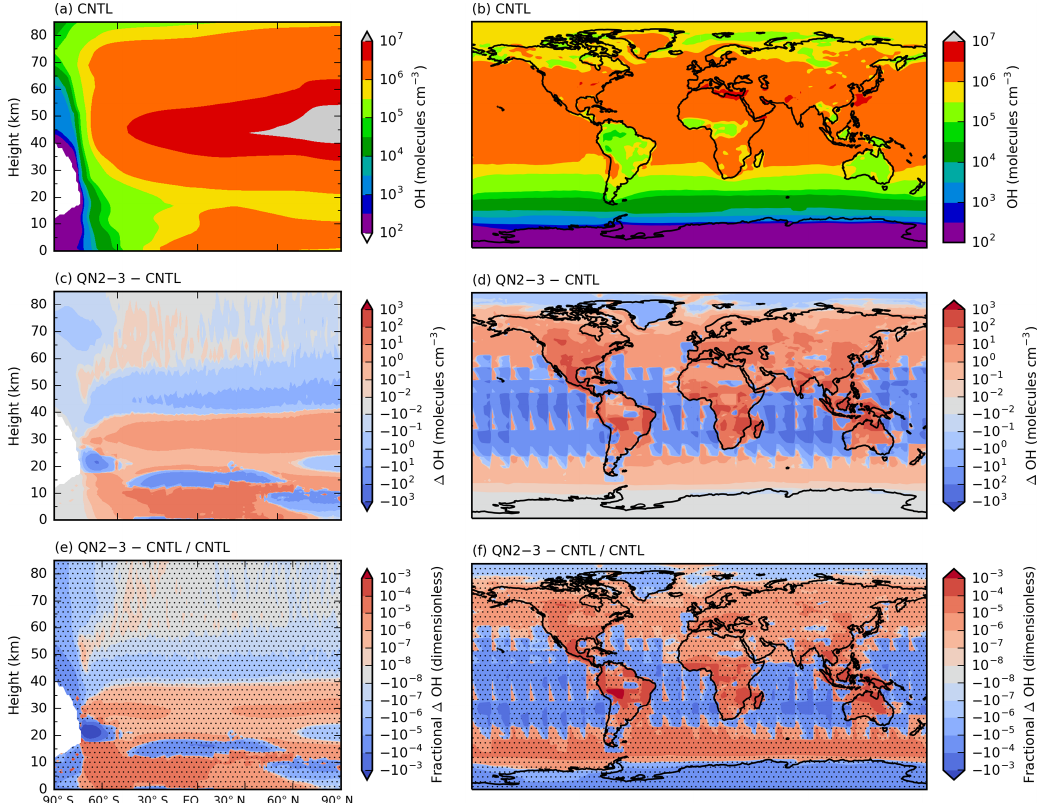
Figure 8. As Fig. 7 but for OH. Note the use of a log scale in the top (CNTL) plots. Note that the model domains are visible due to the extremely small differences in